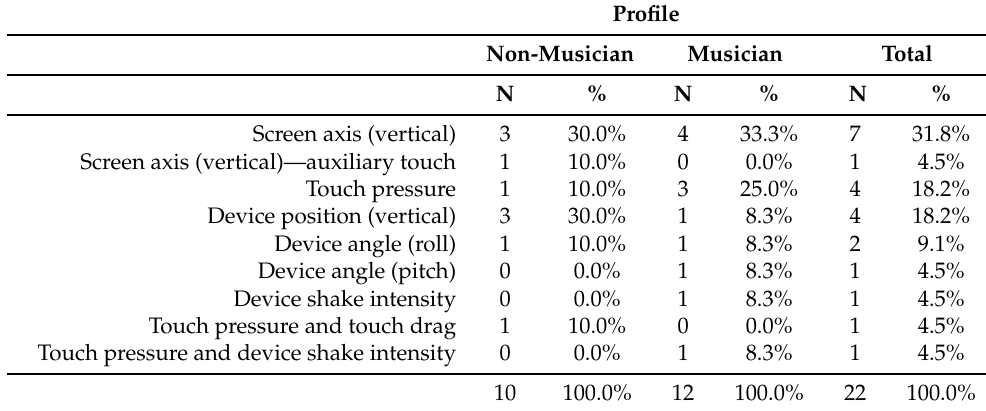
Table A5. Amplitude variation mapping (uncategorized)—stimulus